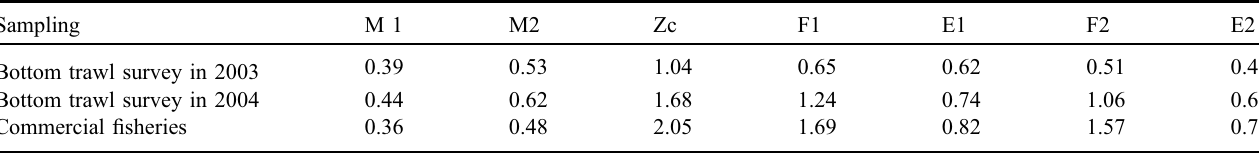
Table 5. Exploitation indices for P. blennoides from the Algerian coast. Natural mortality from Djabali ’ s equation (M1) and Pauly ’ s equation (M2); Zc: total mortality from converted catch curve using FISAT II software; F1: fi shing mortality using M1 and Zc; F2: fi shing mortality using M2 and Zc; E1 and E2 exploitation rates using